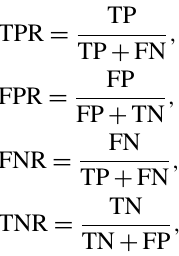
sented by calculating true positive rate (TPR), false positive rate (FPR), false negative rate (FNR), and true negative rate (TNR). These four rates are also widely utilized to exhibit the predictive capability of a prediction model (Hoang and Tien-Bui, 2016).